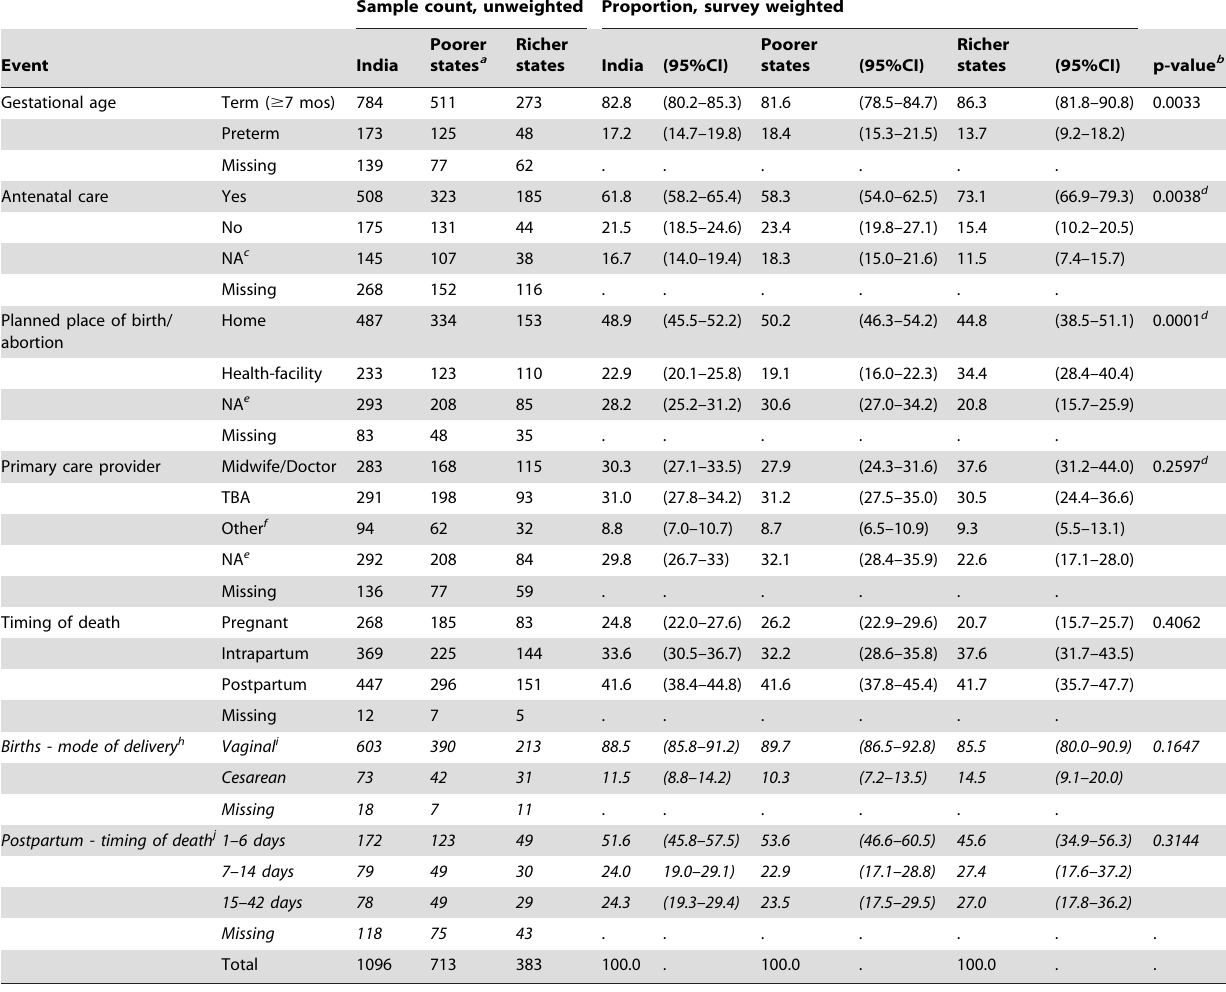
Sample count, unweighted Proportion, survey